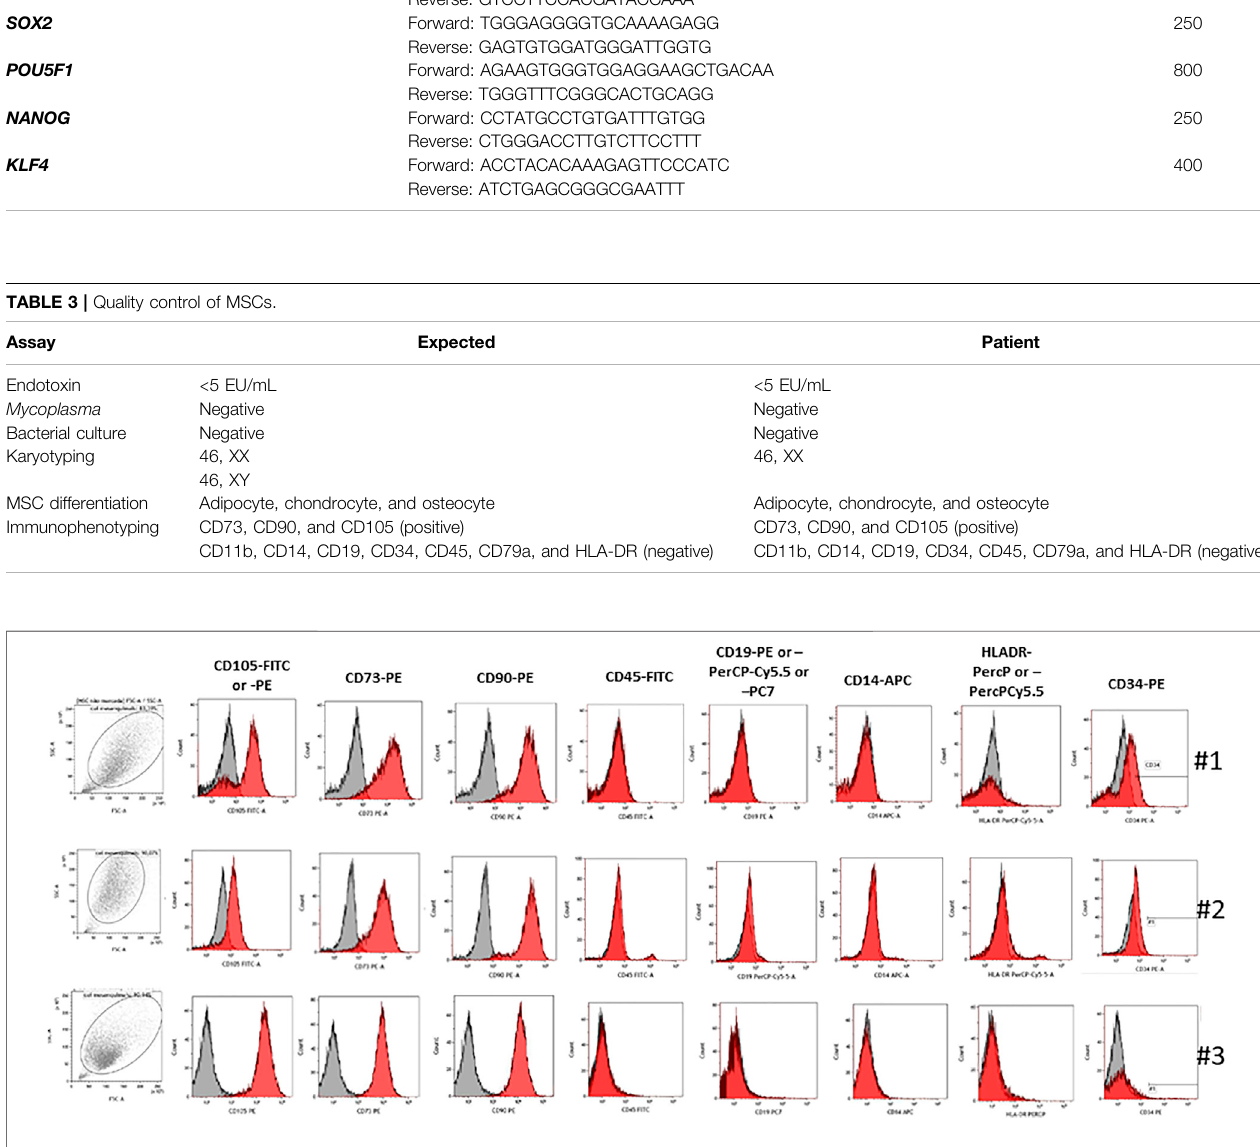
FIGURE 1 | Immunophenotyping of MSCs from the healthy donor and senescence patient. Representative histograms of expression for MSCs derived from bone marrowfromthehealthydonorand senescencepatient.CellsstainedpositiveforCD90,CD105,and CD73,andtheywerenegativeforCD14,CD19,CD45,CD34,and